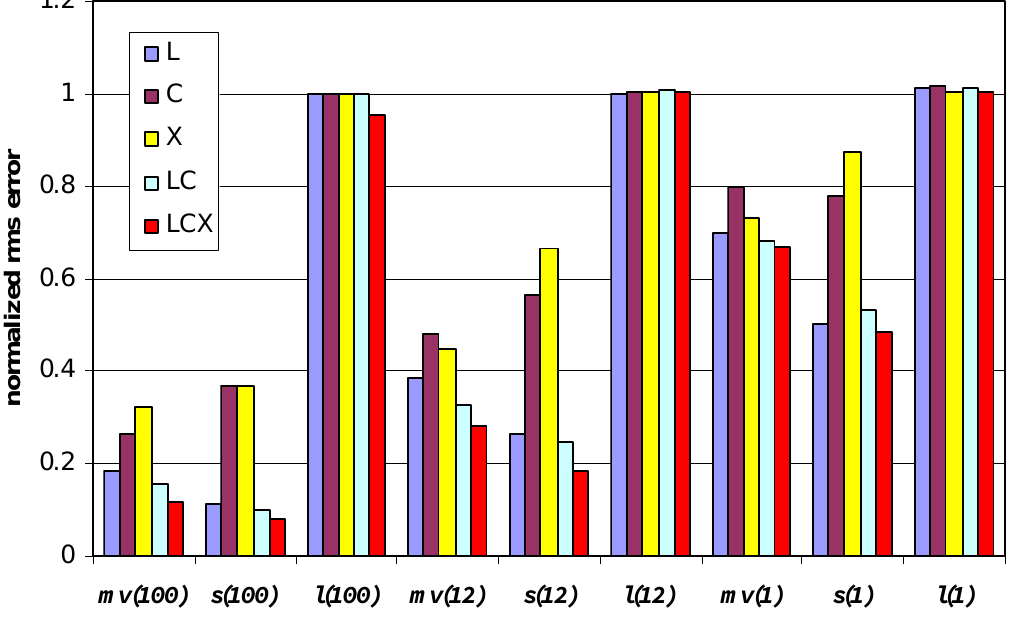
Figure 4 . Same as Figure 3 , but the simulations have been performed with SEM model and X band is also considered (both alone and in conjunction with L and C